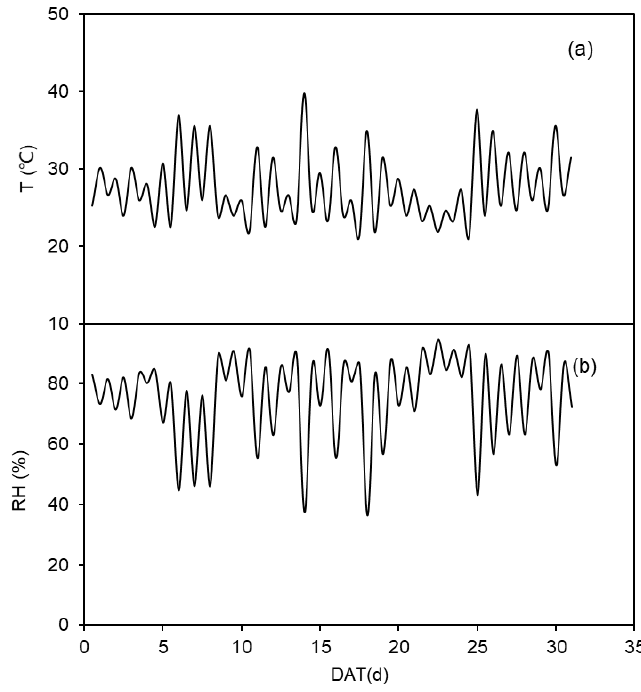
Figure 1. ( a ) The maximum and minimum daily temperature (T, °C) and ( b ) the daily maximum minimum relative humidity (RH, %) in the greenhouse during the treatment and minimum relative humidity (RH, %) in the greenhouse during the treatment period.